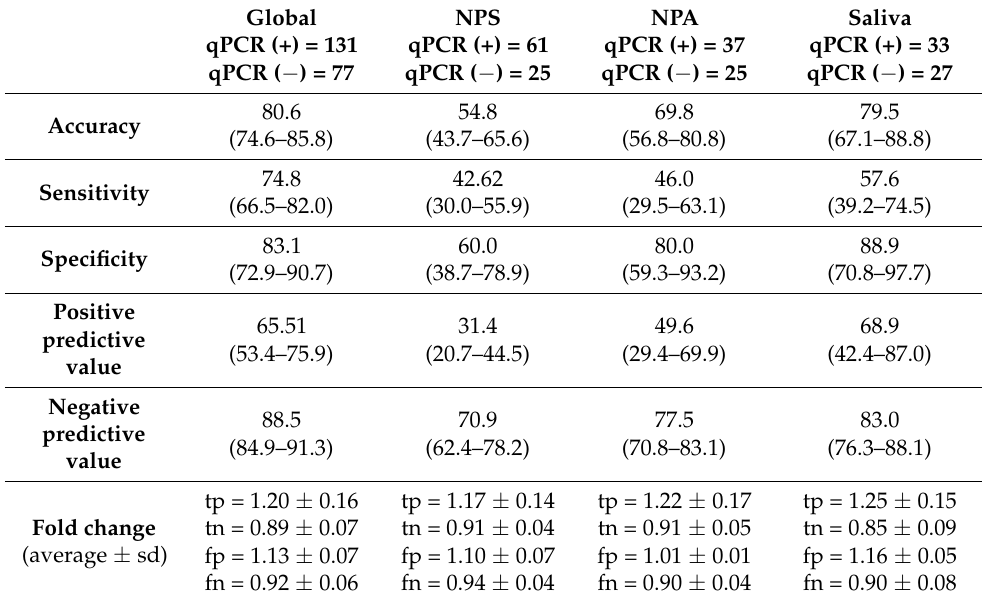
Table 4. Performance of the assay with application-assisted